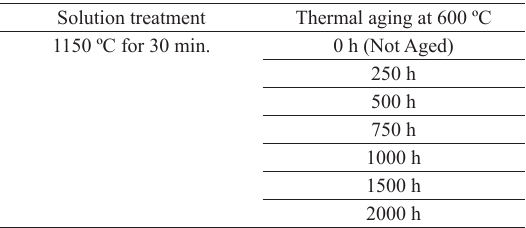
Table 2. Solution treatment condition and several aging conditions adopted for this work. Solution treatment